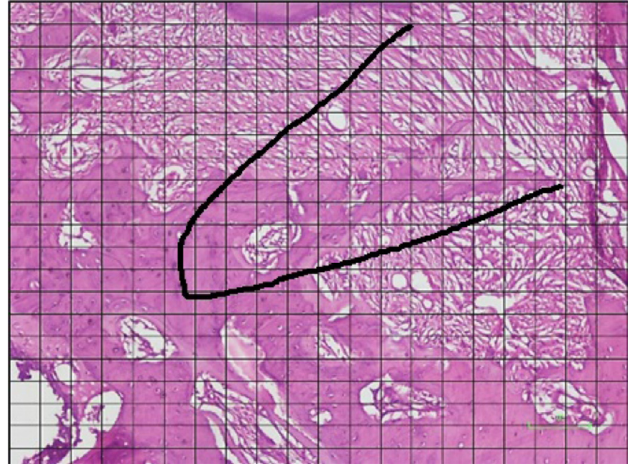
Fig. 3. Measuring percentage of bone trabeculae at